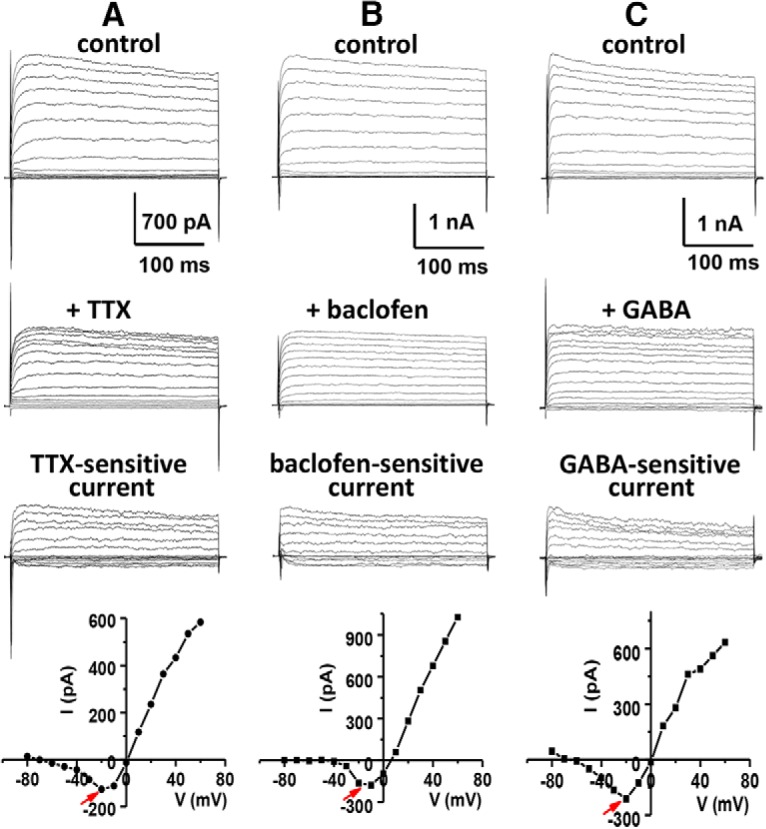
TTX, baclofen, and GABA all inhibit inward and outward currents. Representative traces of whole-cell currents recorded from cultured rat mitral cells in the absence and presence of 0.2 µM TTX (A), 10 µM baclofen (B), or 100 µM GABA (C). The top traces show the control currents evoked from a holding potential of –70 mV in steps from –80 to 60 mV in 10-mV intervals. The middle traces show the residual currents after application of TTX (A), baclofen (B), or GABA (C). The bottom traces show TTX-sensitive (A), baclofen-sensitive (B), or GABA-sensitive (C) current that is obtained by subtraction of the residual current (after drug application) from the control current (before drug application). After application of TTX, baclofen, or GABA, the outward current reduction at 40 mV was 26.8 ± 2.4% (n = 12, p < 0.0001), 30.4 ± 2.5% (n = 12, p < 0.0001), or 22.9 ± 2.1% (n = 5, p < 0.0001), respectively. The I-V plot determined from steady-state values of drug-sensitive current is given below each group of sample traces. The removed inward component of current is indicated by an arrow. Note that the current/voltage plots below the current traces indicate steady state current measured ∼250 ms after the initiation of the step pulses. Because of the overlap of rapidly activating inward and outward currents at the initiation of the step pulses, the currents shown in the first few milliseconds of the traces may not be an accurate depiction of their kinetic properties.